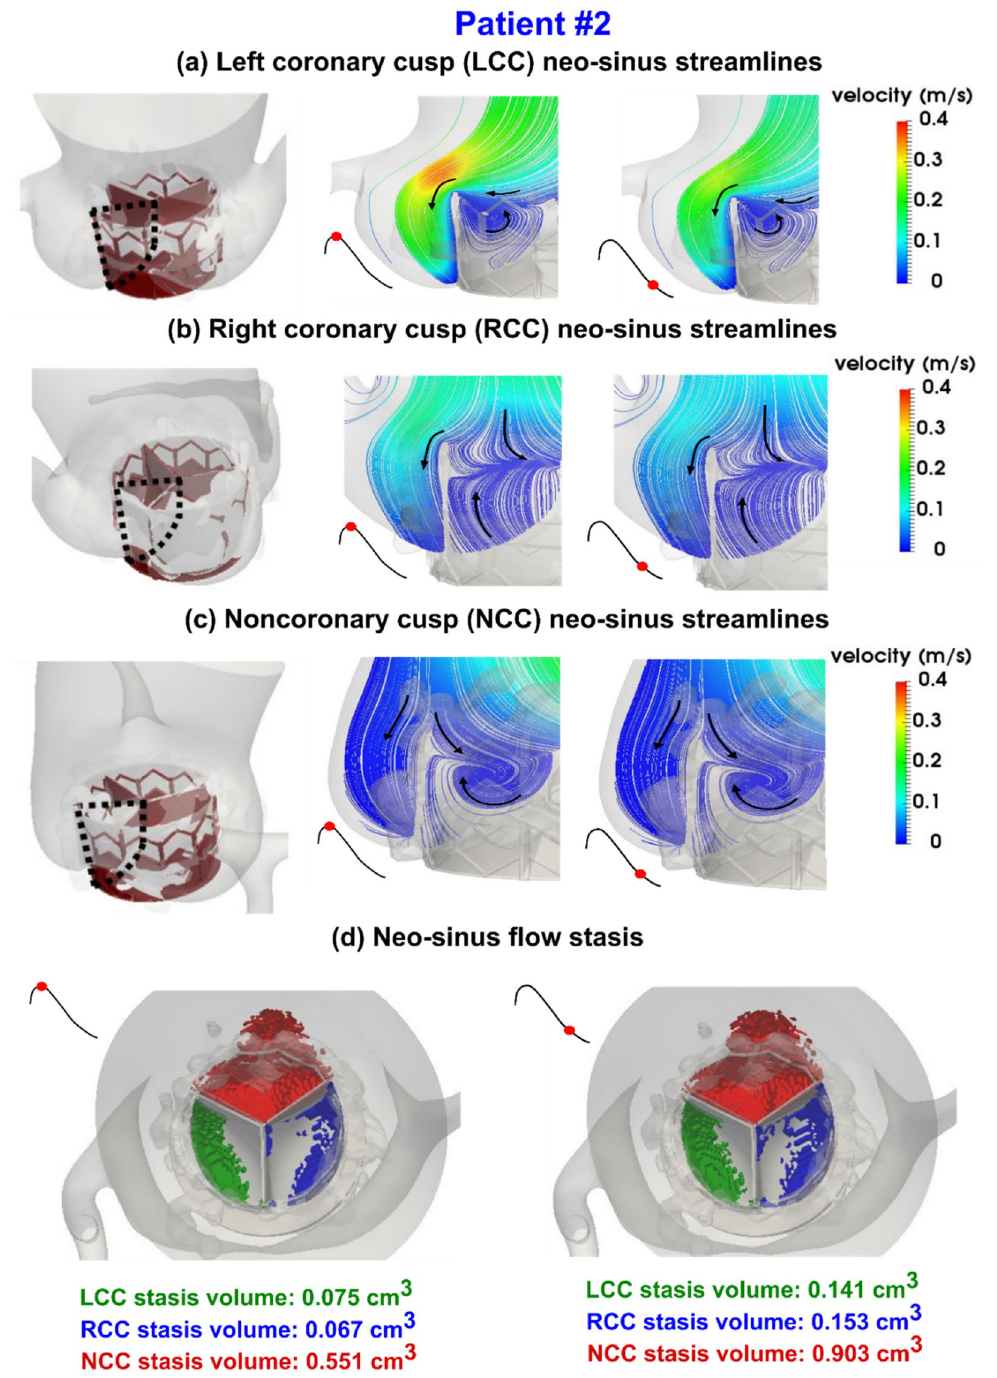
Figure 10. Evolution of vortical structure following TAVR in the aortic root and neo-sinus regions in patient #2 during diastole. ( a ) Mid-planar velocity of left coronary cusp neo-sinus; ( b ) Mid-planar velocity of right coronary cusp neo-sinus; ( c ) Mid-planar velocity of non-coronary cusp neo-sinus; ( d ) Blood stasis volume. Pre- TAVR : severe aortic stenosis (EOA = 0.6 cm 2 ), coronary artery disease and dyslipidemia, diastolic dysfunction, ejection fraction: 38%, brachial pressures: 54 and 107 mmHg, forward LV stroke volume: 74 mL; Post- TAVR : aortic valve (EOA = 1.8 cm 2 ), diastolic dysfunction, ejection fraction: 51%, brachial pressures: 59 and 120 mmHg, forward LV stroke volume: 92